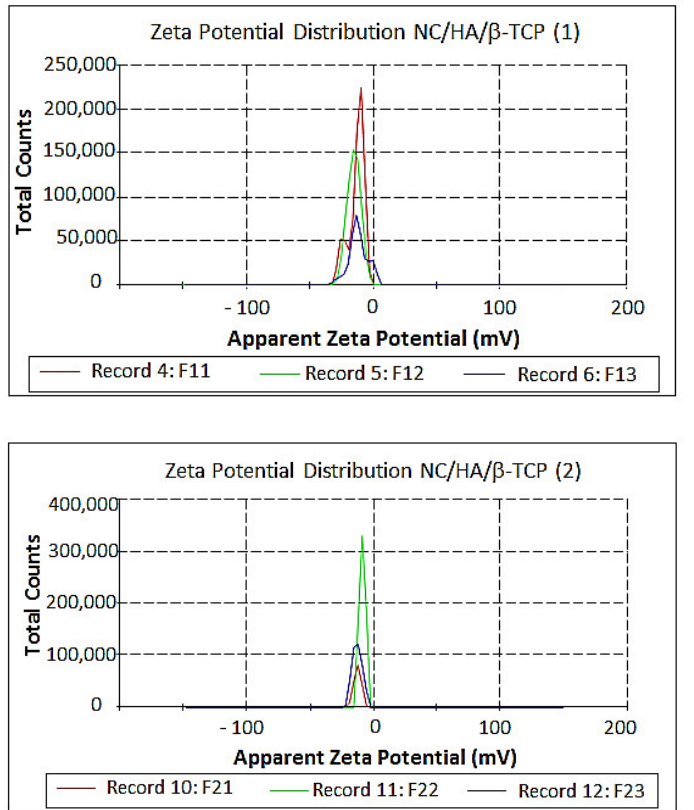
Figure 8. Zeta potential of NC/HA/β-TCP (immediately after hydrolysis), NC/HA/β-TCP (1) (30 days of hydrolysis) and NC/HA/β-TCP (2) (60 days of hydrolysis). The particle size distributions (Figure 9) were found using three records for each of the samples and are listed in Table S2 of the Supplementary Material.